Question: What form of chart is displayed?
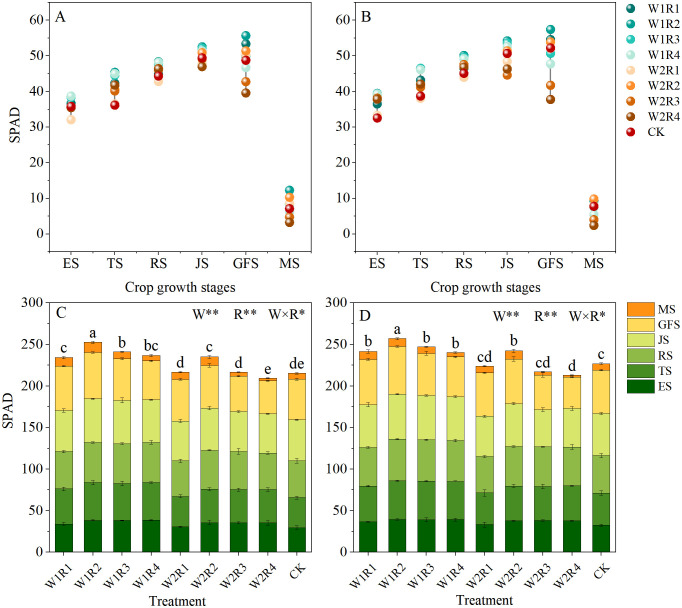
Answer: bar